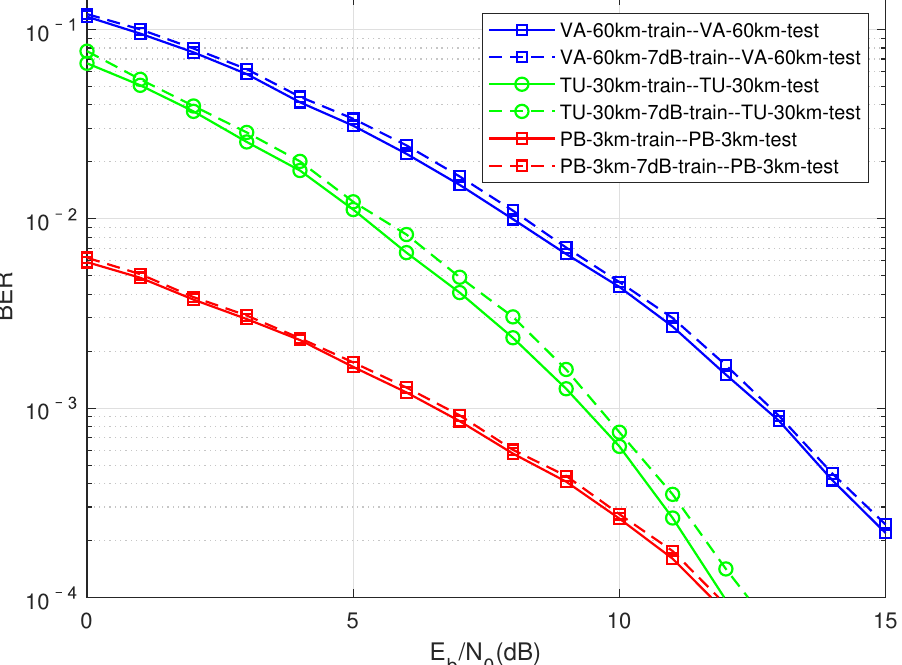
Figure 8. Compression factor τ = 0.7, fixed signal-to-noise ratio (7 dB) for training, and test perfor- mance for the same multipath channel with different signal-to-noise